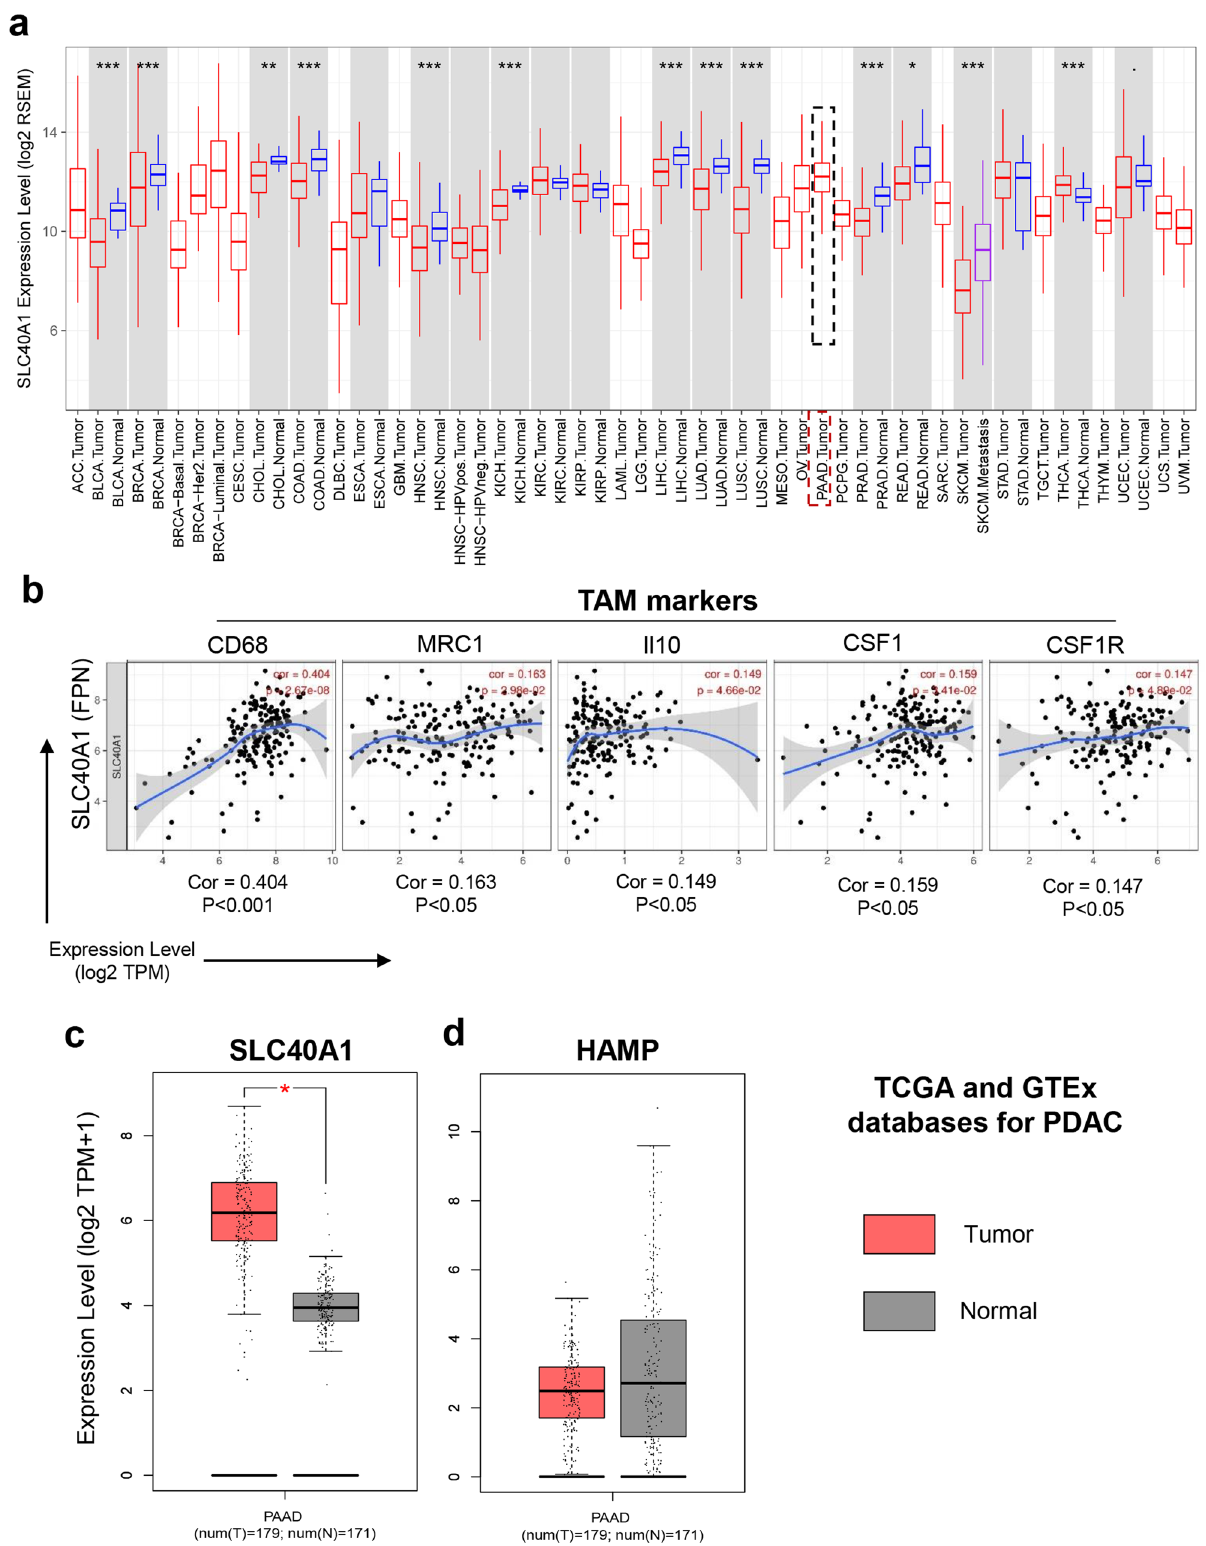
Fig. 5 SLC40A1 expression is upregulated in pancreatic cancer tumor tissues compared to normal pancreas. SLC40A1 also correlates positively with TAMs signature in pancreatic tumors. a Differential expression of SLC40A1(in blue rectangle) across different normal tissue (blue) and cancer (red) types as determined using online resource TIMER for TCGA data. b Correlation of SLC40A1 gene expression with TAMs gene signature in pancreatic tumors as determined using TIMER. Differential gene expression levels between normal pancreas and pancreatic tumors for ( c ) SLC40A1 and ( d ) HAMP as determined by GEPIA2 online